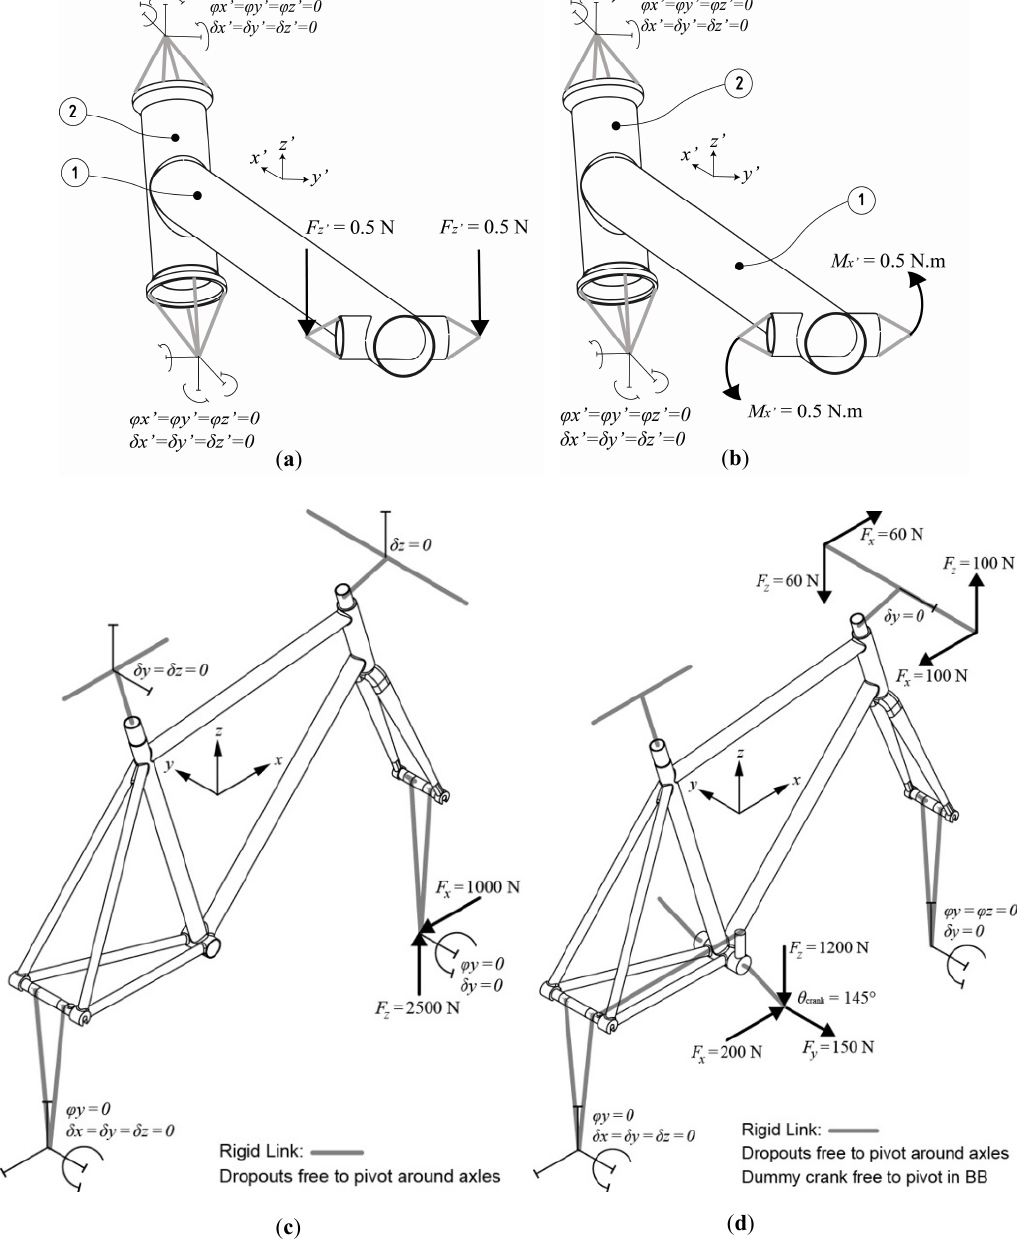
Figure 1. Geometry/boundary conditions for Model 1 (single down tube-head tube joint with 1-down tube; 2-head tube) in ( a ) bending and ( b ) torsion in the down tube; and for Model 2 (whole frame) subjected to ( c ) in-plane bending due to a road bump at the front wheel, and ( d ) out of plane bending/torsion due to climbing out of the saddle. Both ( c ) and ( d ) were based on loads from